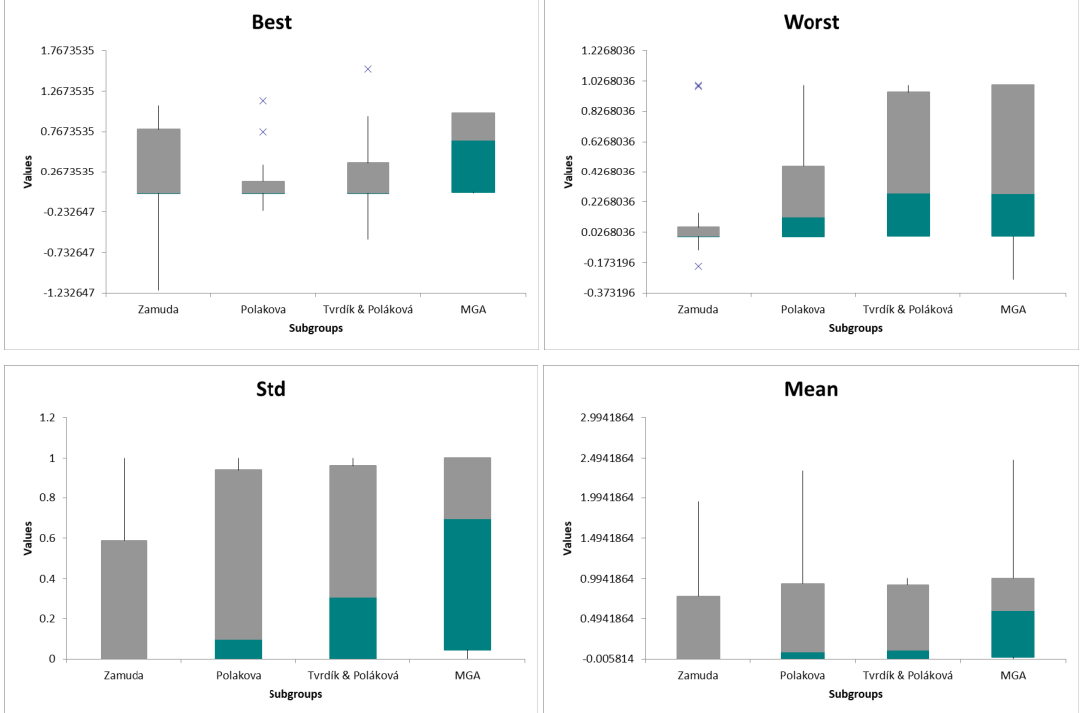
Figure 8. Box plots of the ANOVA for the 30-dimensional problems.